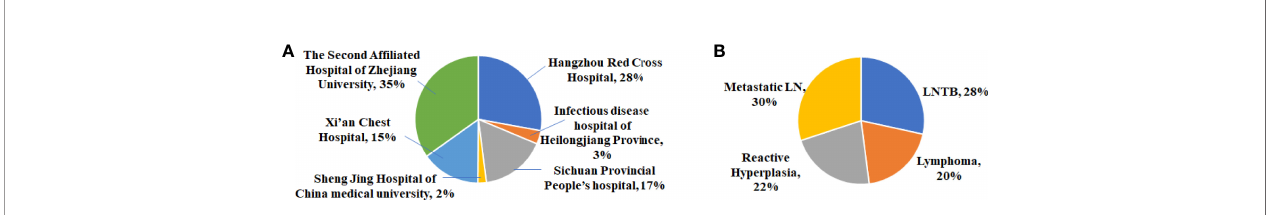
FIGURE 1 | (A) Distribution of cervical lymphadenopathy in six medical centers. (B) Distribution of four categories of cervical